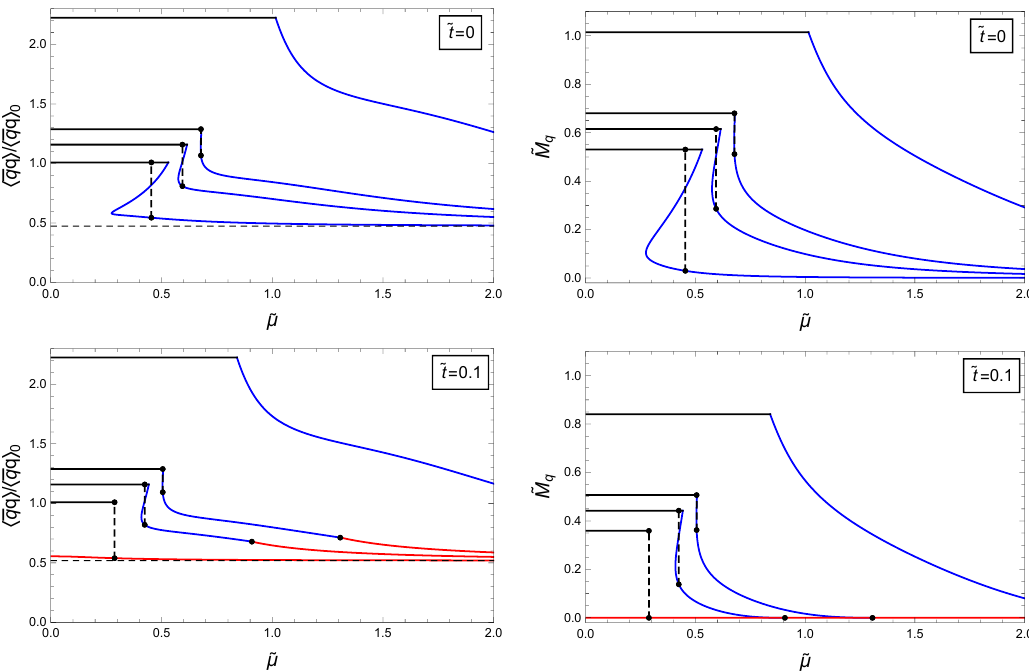
Figure 3 . Chiral condensate normalized to its vacuum value at zero current quark mass (left panels) and constituent quark mass (right panels) for zero temperature (upper panels) and a nonzero temperature ~ t = 0 : 1 (lower panels). In all panels, the mass parameter is ~ (cid:11) = 0 : 001 ; 0 : 02 ; 0 : 04 ; 0 : 2 from top to bottom. The vertical dashed segments indicate (cid:12)rst-order phase transitions, i.e., some segments of the solid lines are unstable or metastable. The thin horizontal dashed lines in the left panels indicate the asymptotic value (4.1) that all curves approach for ~ (cid:22) ! 1